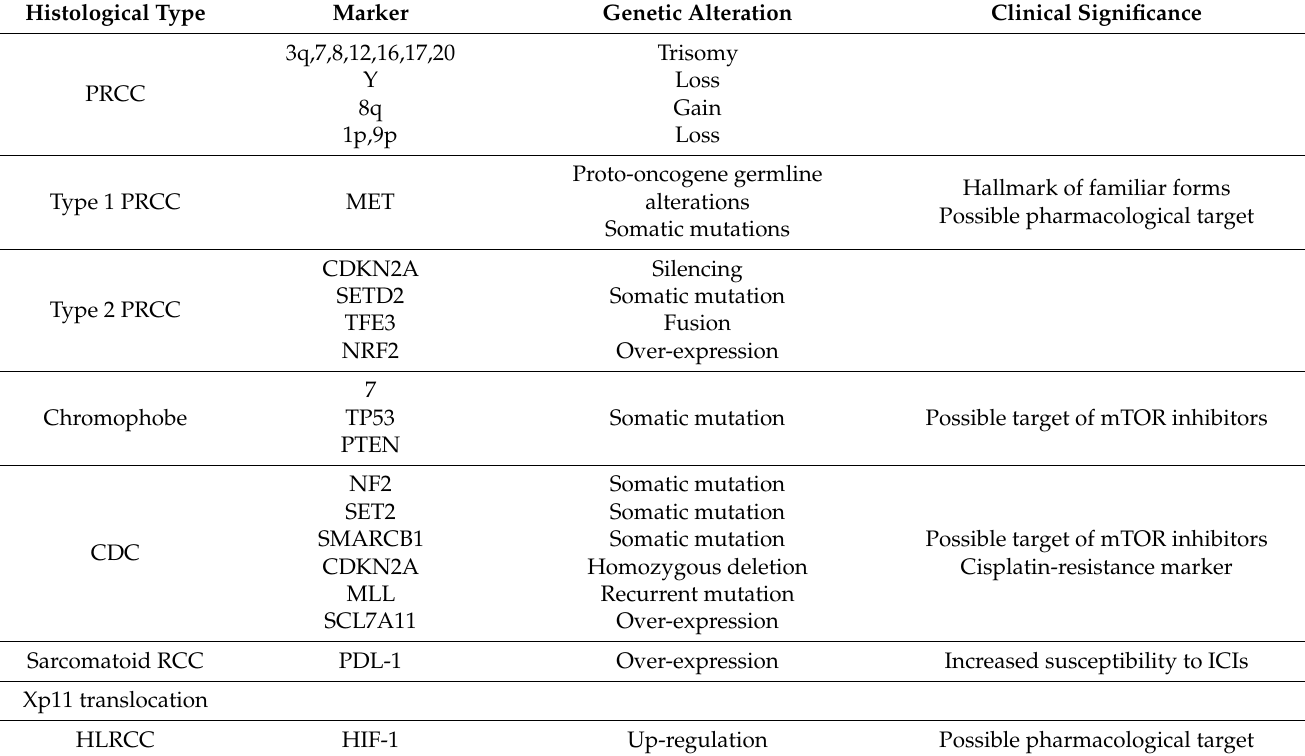
Table 1. Summary of key genetic and cytogenetic alterations in nc-RCC. PRCC: papillary renal cell carcinoma. CDC: collecting duct carcinoma. HLRCC: Hereditary leiomyomatosis and renal cell carcinoma. Histological